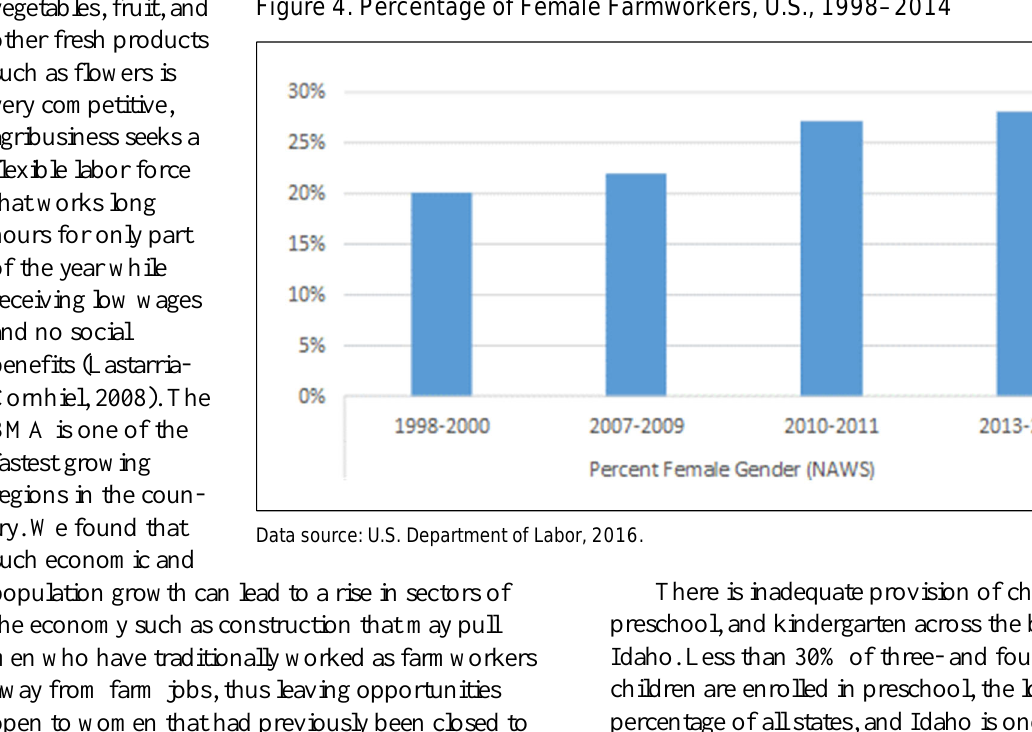
Figure 4. Percentage of Female Farmworkers, U.S., 1998–2014